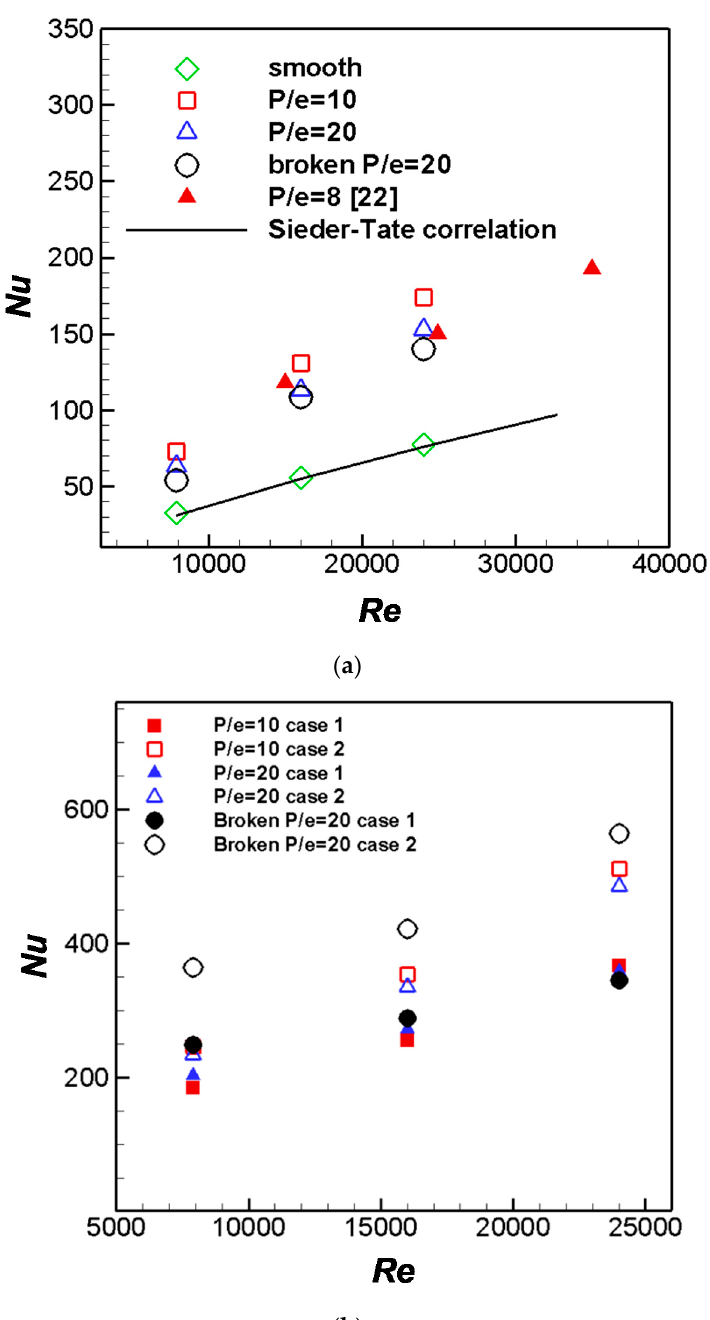
Figure 11. Overall-averaged Nusselt numbers for ( a ) air flow and ( b ) mist flow.